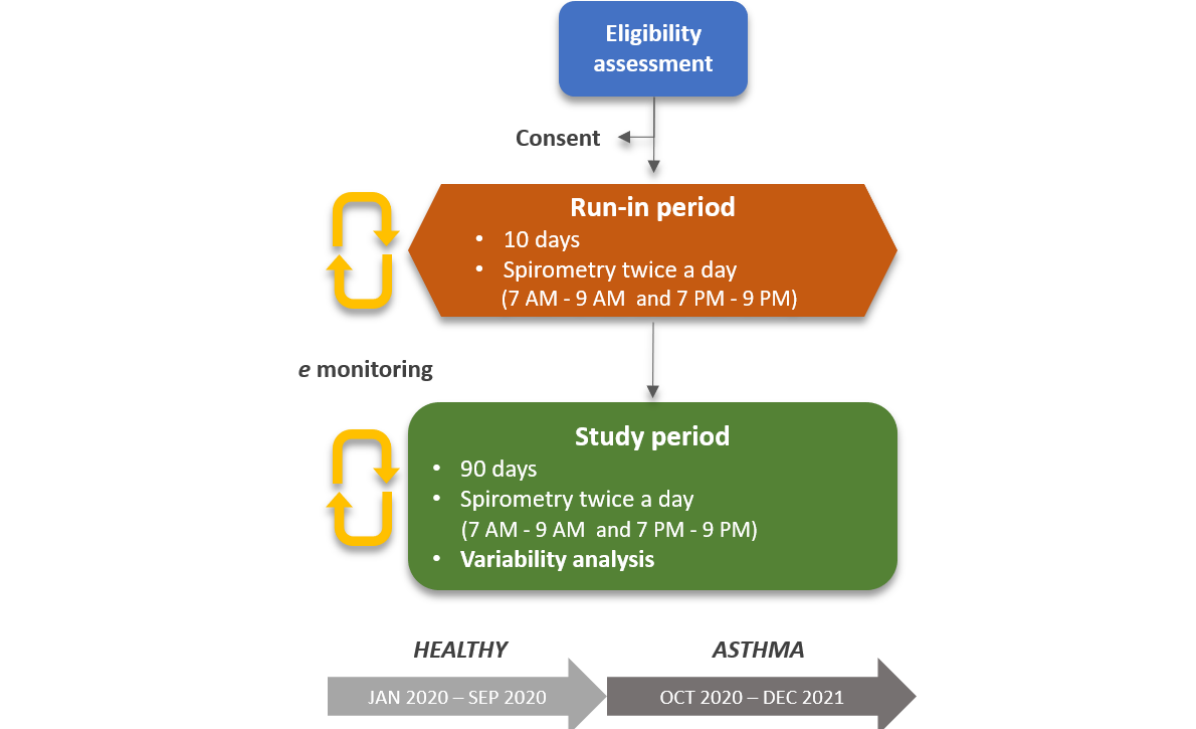
Figure 1. Study flow